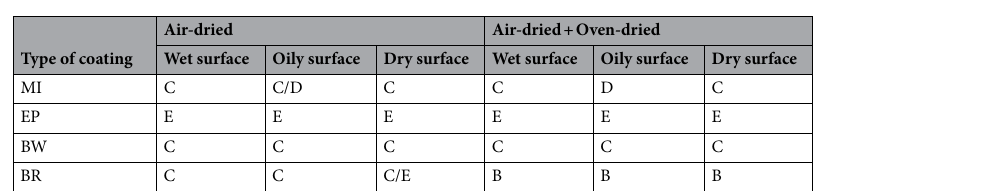
Figure 11. Types of fracture according to its nature: ( a ) Glue failure ( b ) Adhesive failure (between layers) ( c ) Cohesive failure (within a layer) ( d ) coating failure ( e ) Substrate failure ( f ) 50% cohesive failure and 50% coating failure.